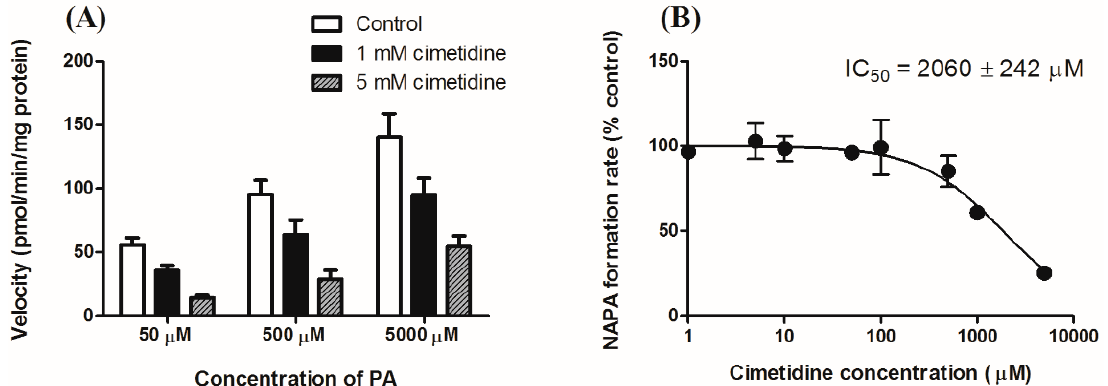
Figure 3. Effects of cimetidine on the metabolic conversion of PA to NAPA using in vitro rat liver S9 fraction. ( A ) Dependence of the metabolic conversion rate on the PA concentration in rat liver S9 fractions (50, 500, and 5000 µ M) ( n = 5 for each column) ( B ) Inhibitory effects of cimetidine on the conversion rate of PA to NAPA in rat liver S9 fractions (three independent experiments with triplicate measurement) ( n = 3 for each point). Symbols represent the mean ± S.D.